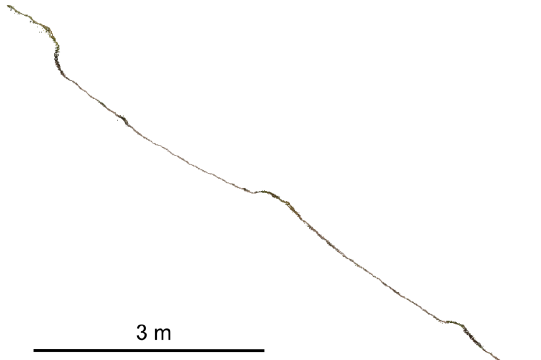
Figure 2: Cross-section through a point cloud visualized in Cloud Compare (Girardeau-Montaut, 2011). The eroded area scarp (upper left) and two clods of soil within the eroded area (middle and lower right) can be identified.